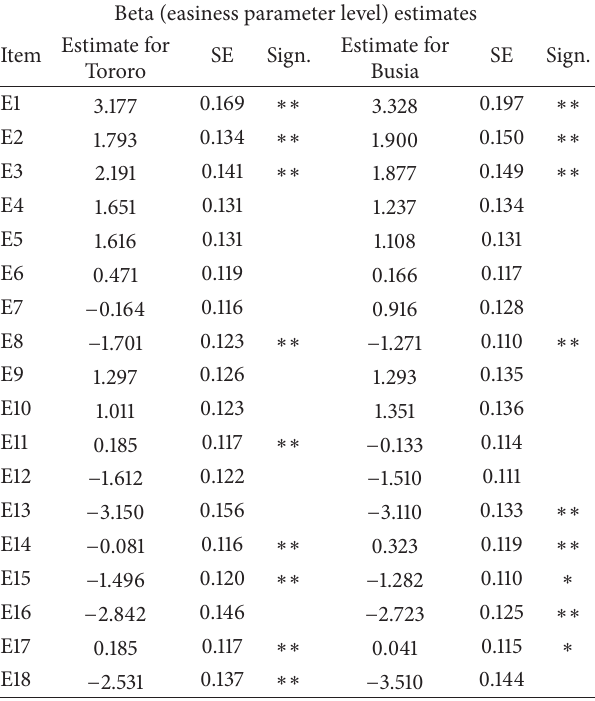
Table 4: Estimated beta coefficients of the Rasch model for Tororo and Busia districts.